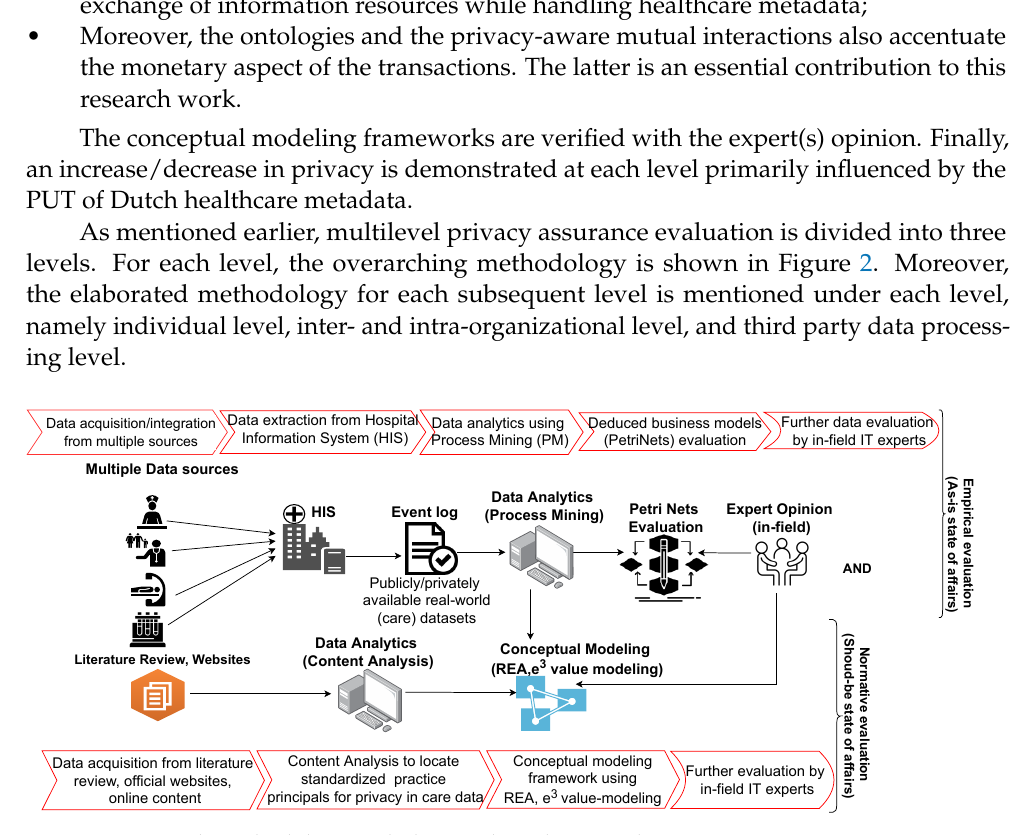
Figure 2. Research methodology with data analytical